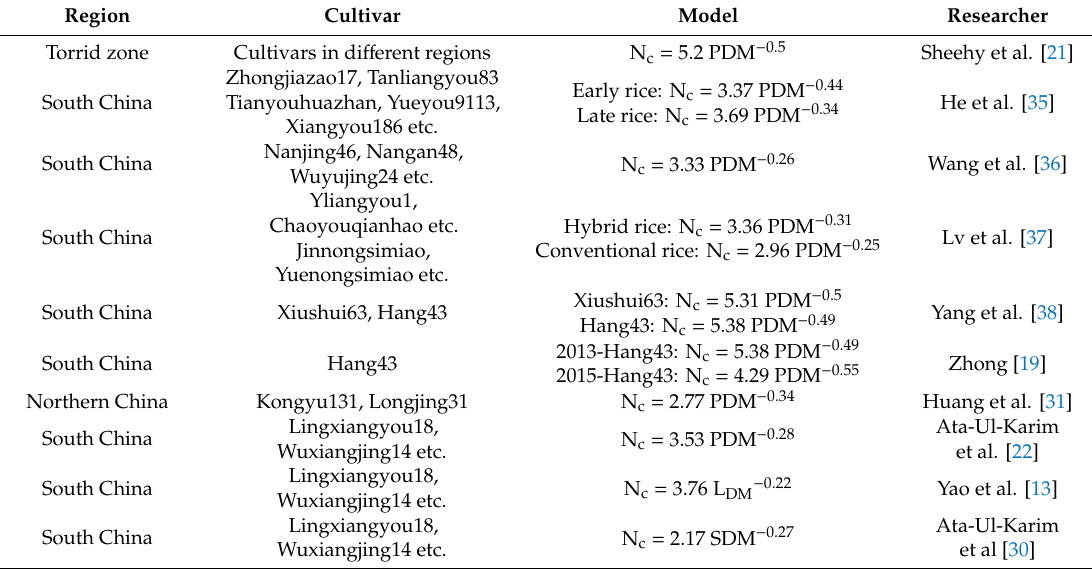
Table 2. Summary of critical nitrogen